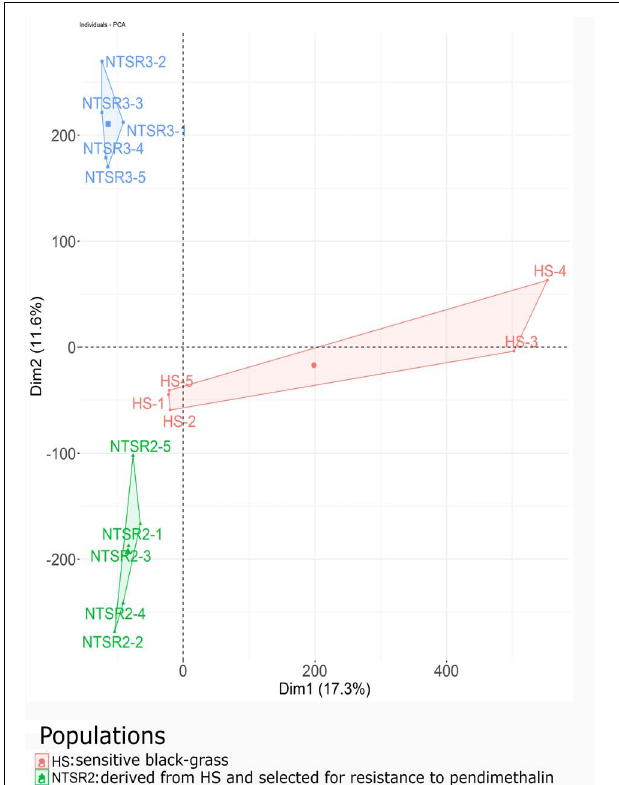
FIGURE 4 | Principal component analysis of the global transcriptional expression profiles of the NTSR2 and NTSR3 black-grass populations were distinct from each other and from HS (Rothamsted) black-grass population. Each point represents one of the five biological replicates (each containing five plants) of each population. Axes represent the percentage of variance explained by each dimension, with the dimension 1 (Dim1) explaining 16.8% and the dimension 2 (Dim2) explaining 11.6% of the variance. HS, sensitive population; NTSR2, derived from HS and selected for resistance to pendimethalin; NTSR3, derived from HS and selected for resistance to fenoxaprop- P -ethyl.